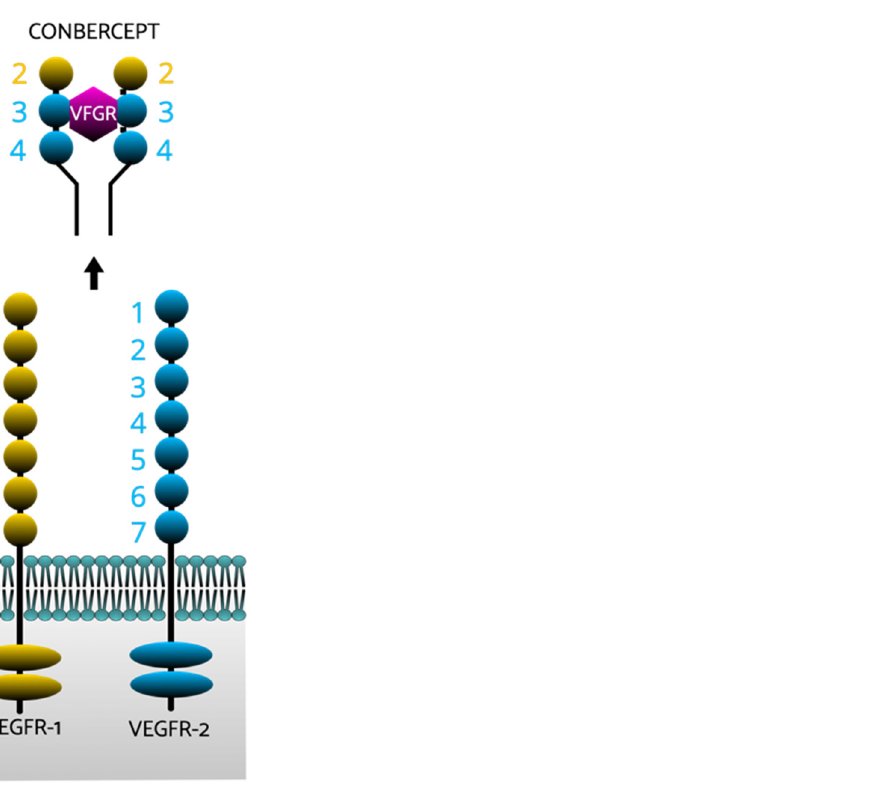
Figure 1. The conbercept molecule. The conbercept molecule is made up of two of the second im- munoglobulins of the vascular endothelial growth factor receptor-1 (VEFGR-1) and two of the third and two of the fourth immunoglobulins of VEFGR-2 [65].